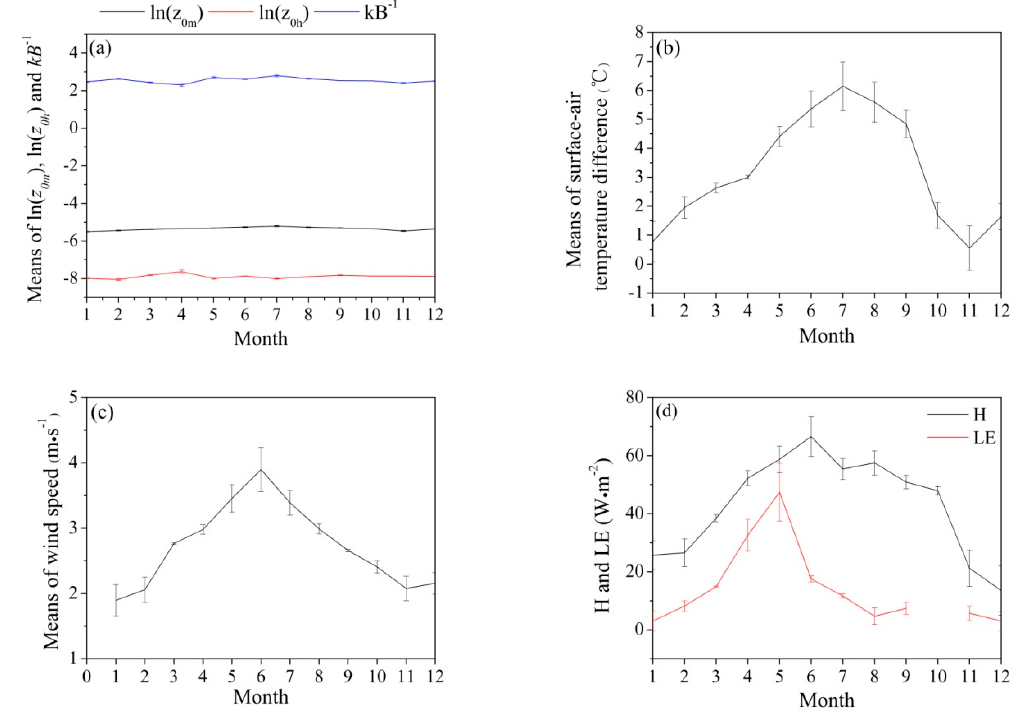
Figure 9. ( a ) Monthly variations in the mean values of ln( z 0 m ), ln( z 0 h ), and kB − 1 from 5 January to 31 December 2010. ( b ) Same as ( a ) but for the surface-air temperature. ( c ) Same as ( a ) but for the wind speed. ( d ) Same as ( a ) but for the sensible heat and latent heat fluxes.